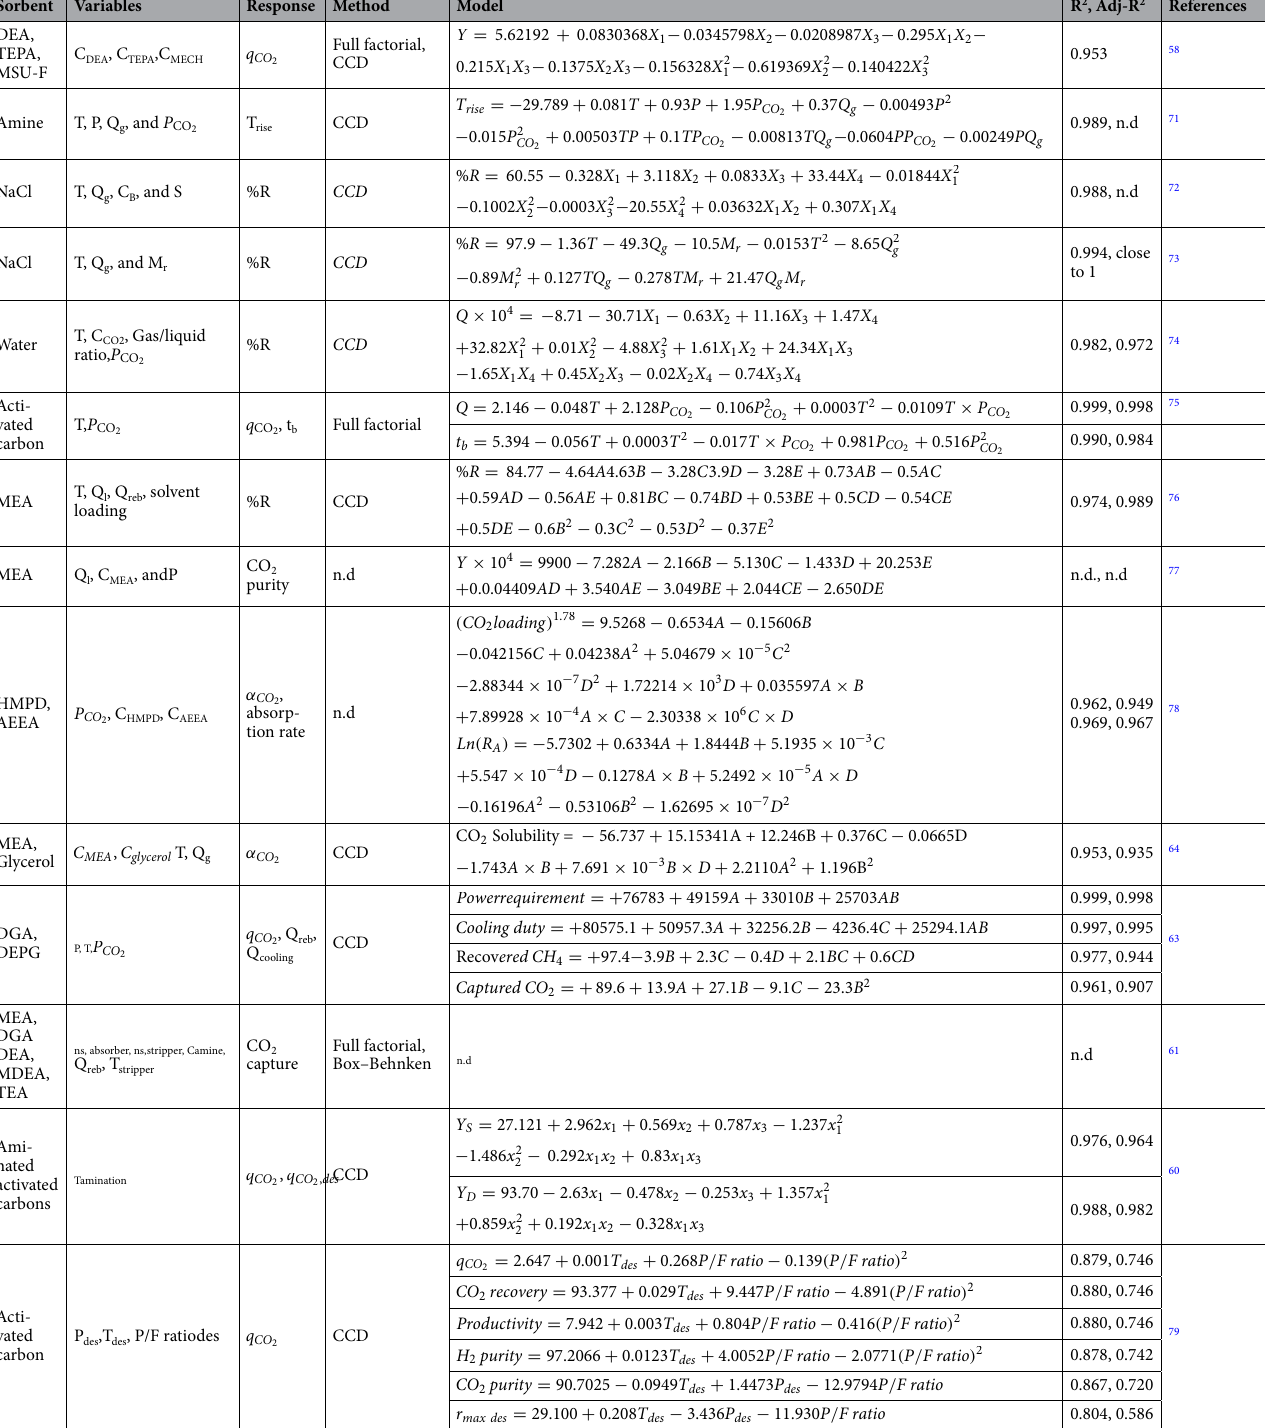
Table 1. Some studies on the performance of CO 2 capture using RSM techniques. n.d. = not